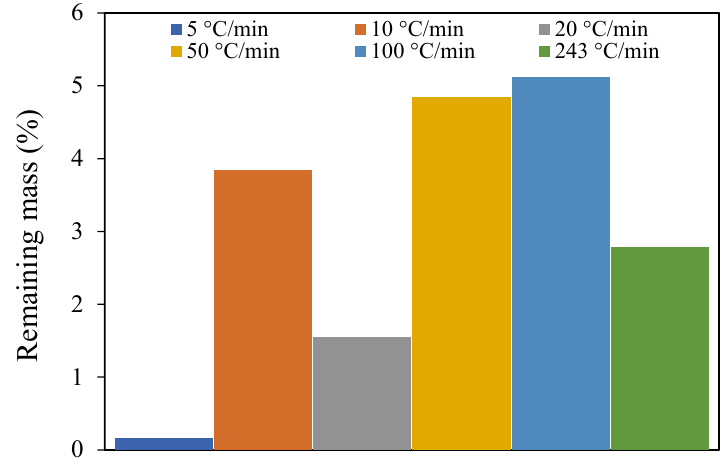
Figure 4. Remaining mass at di ff erent heating rates for particles between 0.125 and 0.25 mm.